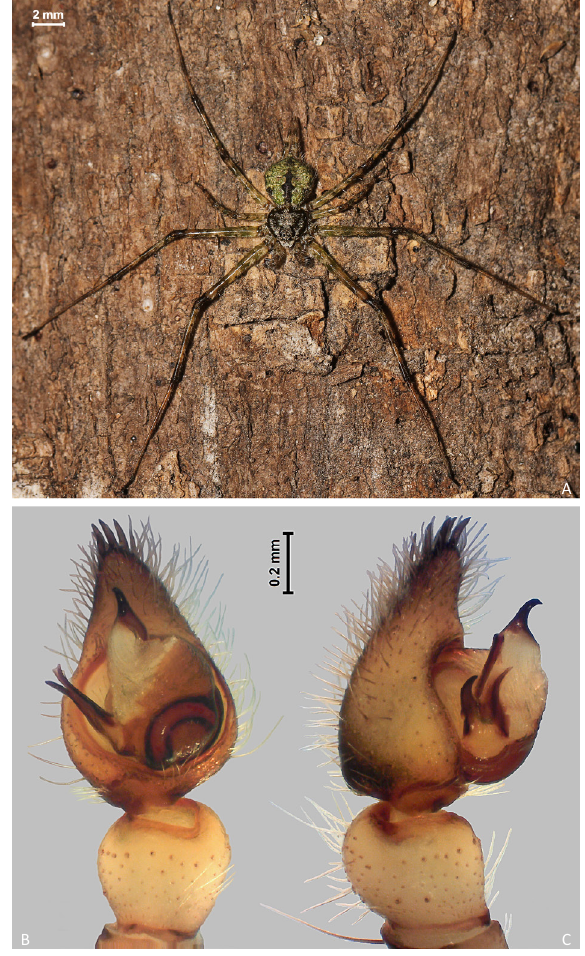
Image 2. Iviraiva pachyura , male. A - specimen alive (FCE-Ar 4818); B - left palp, ventral view (FCE-Ar 4051); C - left palp, retrolateral view (FCE-Ar 4051). © A - Bruno Vivián; B,C - Álvaro Laborda.